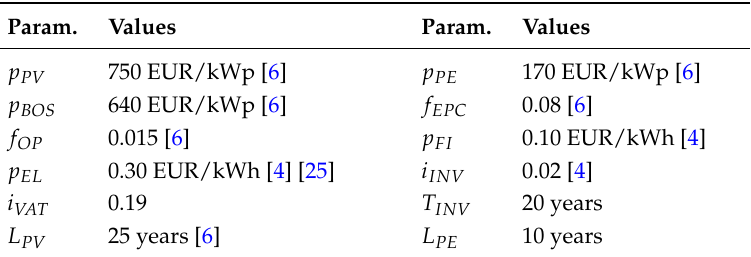
Table 2. Financial